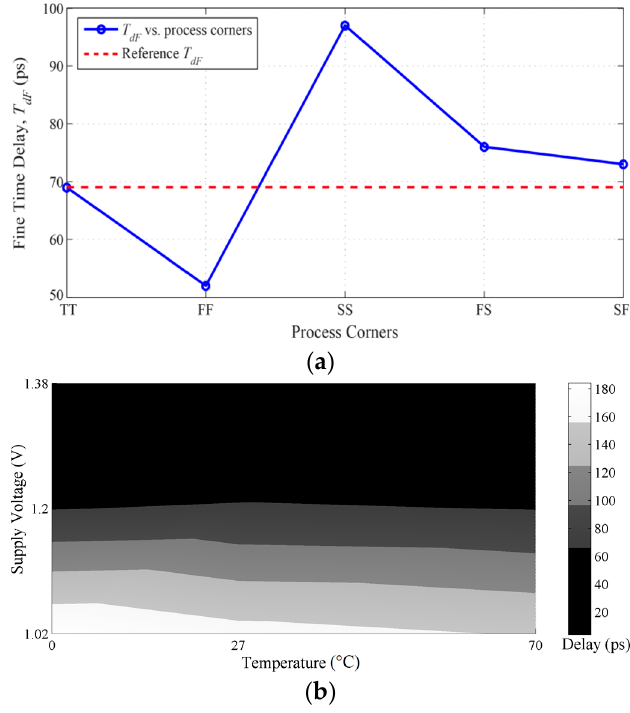
Figure 11. Maximum DLL’s delay range versus: ( a ) process corners; and ( b ) temperature and supply voltage variations.